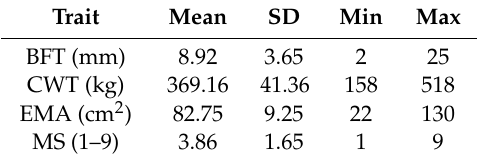
Table 1. Descriptive statistics for four carcass traits in 1161 Hanwoo cattle. Trait